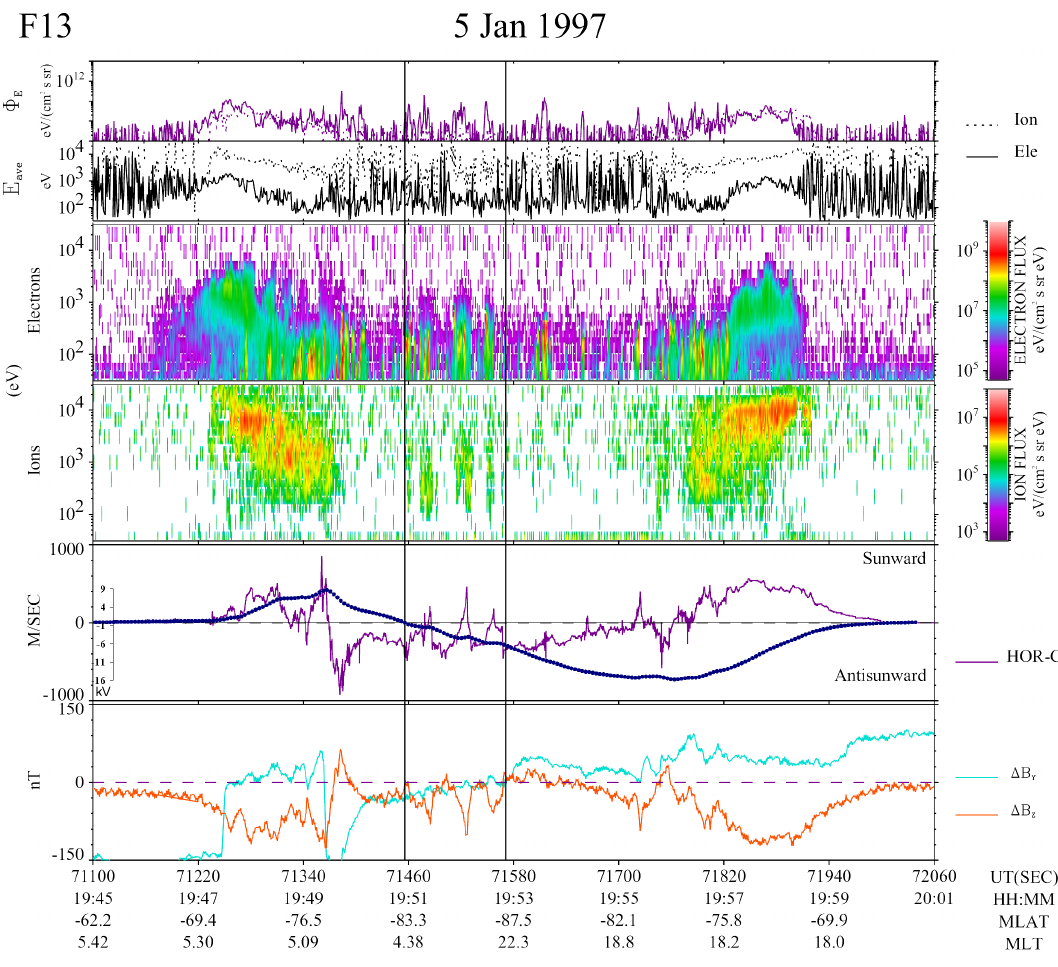
Fig. 1. DMSP F13 polar pass taken on 5 January 1997 in the sunlit Southern Hemisphere. The satellite track is on the nightside of the dawn-dusk meridian and the highest magnetic latitude reached is 87 degrees. Because of the orbit geometry, dawn is on the left hand side and dusk is on the right. The F13 spectrograms include, from top to bottom, (1) electron and ion integral energy flux, (2) electron and ion average energy, (3) electron differential energy flux spectrogram, (4) ion differential energy flux spectrogram, (5) cross-track horizontal plasma drift and along-track electrostatic potential distribution (blue line), (6) 1B y (along track, blue line) and 1B z (sunward, red line). Note that the flux scales are different for the electron and ion